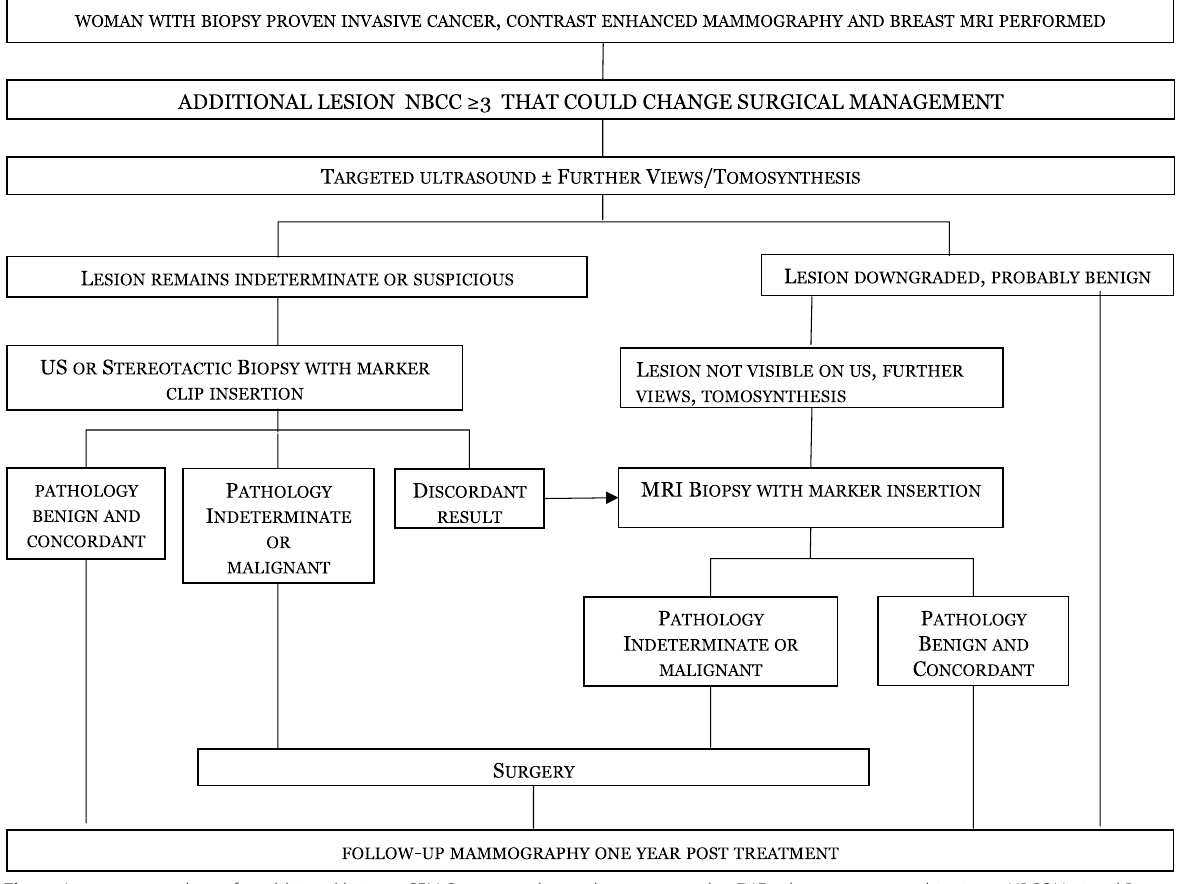
Fig. 1 Assessment pathway for additional lesions. CEM Contrast-enhanced mammography, FV Further mammographic views, NBCC National Breast Cancer Center, Tomo Tomosynthesis, US